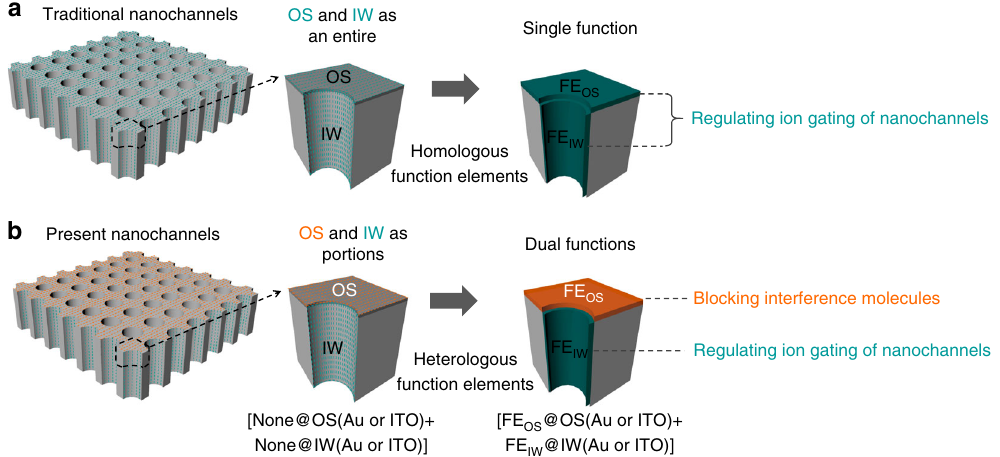
Fig. 1 Nanochannels with dual functions. Traditional nanochannels with single function, while ours with dual functions. a FE IW at IW are considered as the main contributions to ion gating, while FE OS at OS are nearly ignored in traditional nanochannels. b The explicit partition of FE OS and FE IW are achieved based on the accurate regional-modi fi cation of OS and IW. More importantly, FE IW are served for ionic gating, and the chosen FE OS (hydrophobic or charged), to our knowledge, are served for blocking the interference molecules into the nanochannels, decreasing the false signals for the ionic gating,